Question: In one sentence, what is this figure communicating?
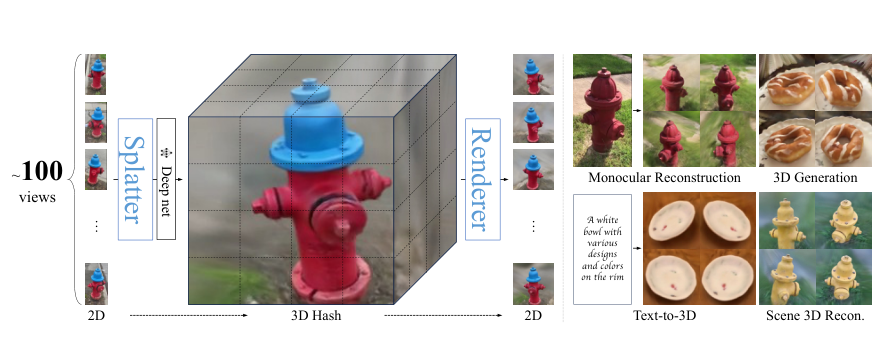
Answer: We introduce the Lightplane Renderer and Splatter, a pair of highly- scalable components for neural 3D fields (left). They address the key memory bot- tleneck of 2D-3D mapping (i.e. rendering and lifting), and reduce memory usage by up to four orders of magnitude, which dramatically increases the number of images that can be processed. We showcase how they can boost various 3D applications (right).